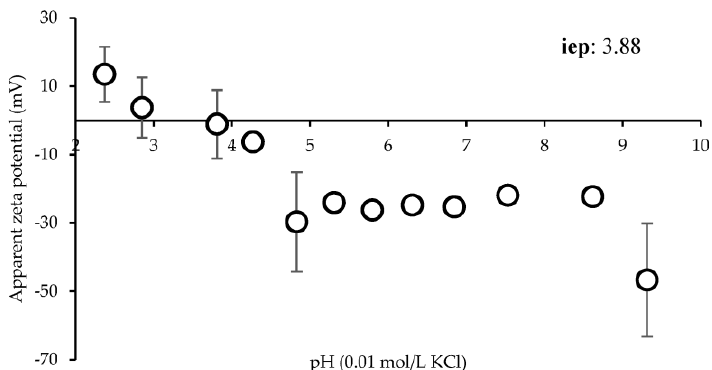
Figure 4. Surface zeta potential of SD crickets (mean ± s.d.; n = 3). In the inset the iep is reported.